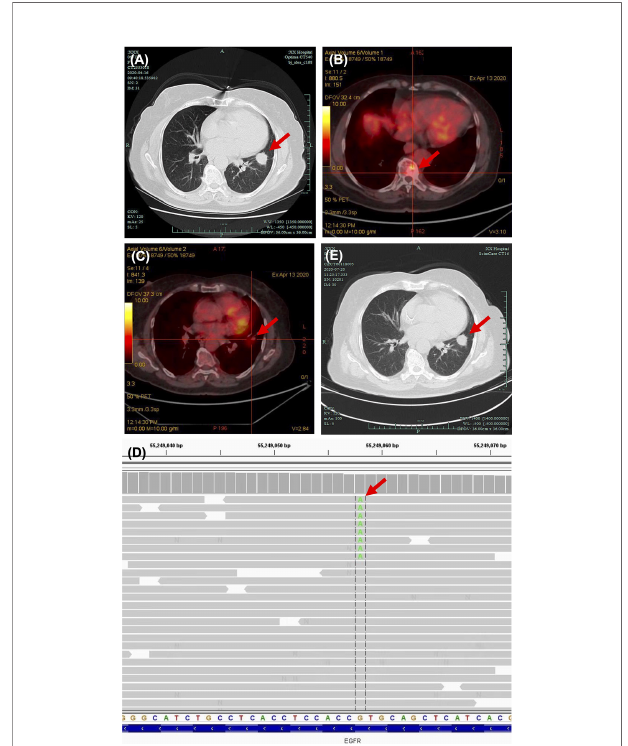
FIGURE 1 | Diagnosis of EGFR V786M mutation and fi rst-line therapy. (A) CT scan of lung window captured on April 16, 2020. Elevated SUV of bone lesion (B) and lung nodule (C) in PET-CT scan. (D) Next-generation sequencing (NGS) panel results showed an epidermal growth factor receptor (EGFR) mutation V786M in exon 20. (E) CT scan of the lung window captured on July 20, 2020, post fi rst-line therapy. Signi fi cant abnormal fi ndings noted ( arrow